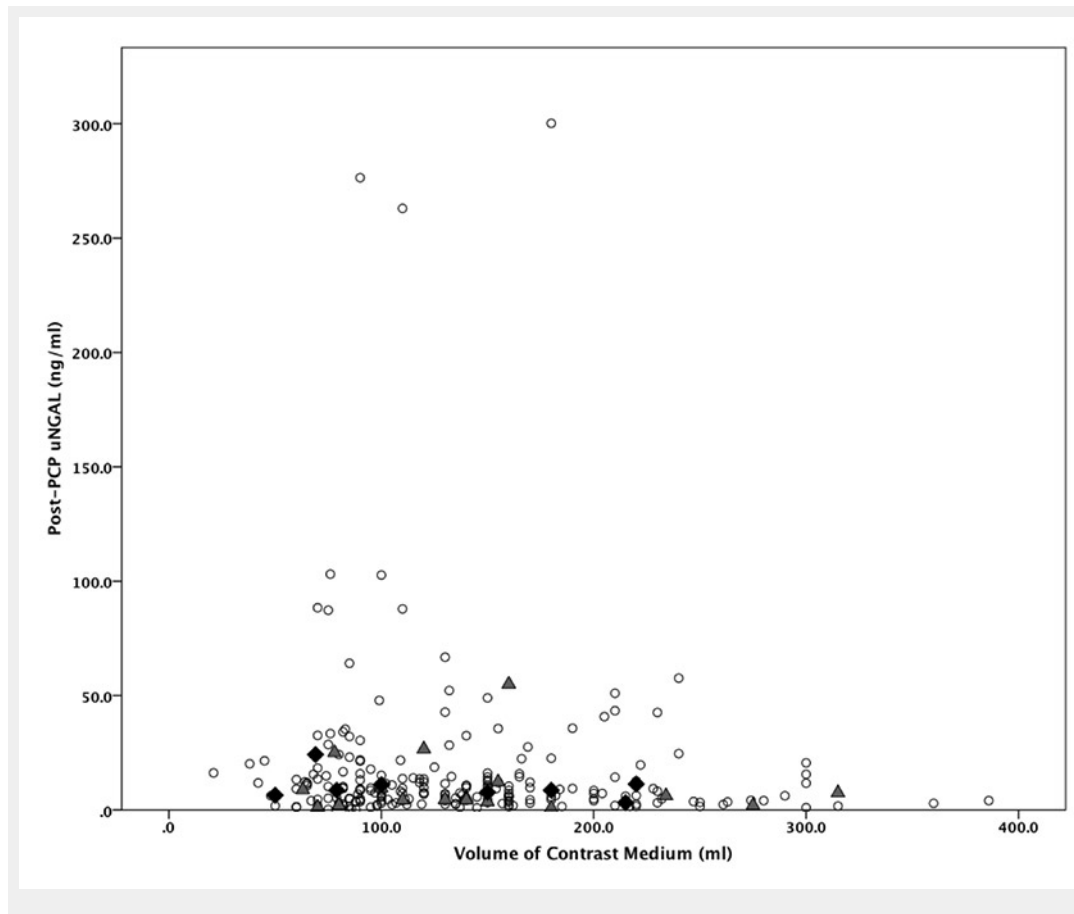
Figure 3 Relationship between the volume of contrast medium used and the post-PCP uNGAL levels in patients without CI-AKI (white disk), and with CI- AKI defined by the classical criteria (grey triangle) or by the AKIN criteria (black diamond) (normal uNGAL range ≤132 ng/ml). CI-AKI = contrast- induced acute kidney injury; PCP = percutaneous coronary procedure; uNGAL = urinary neutrophil gelatinase-associated